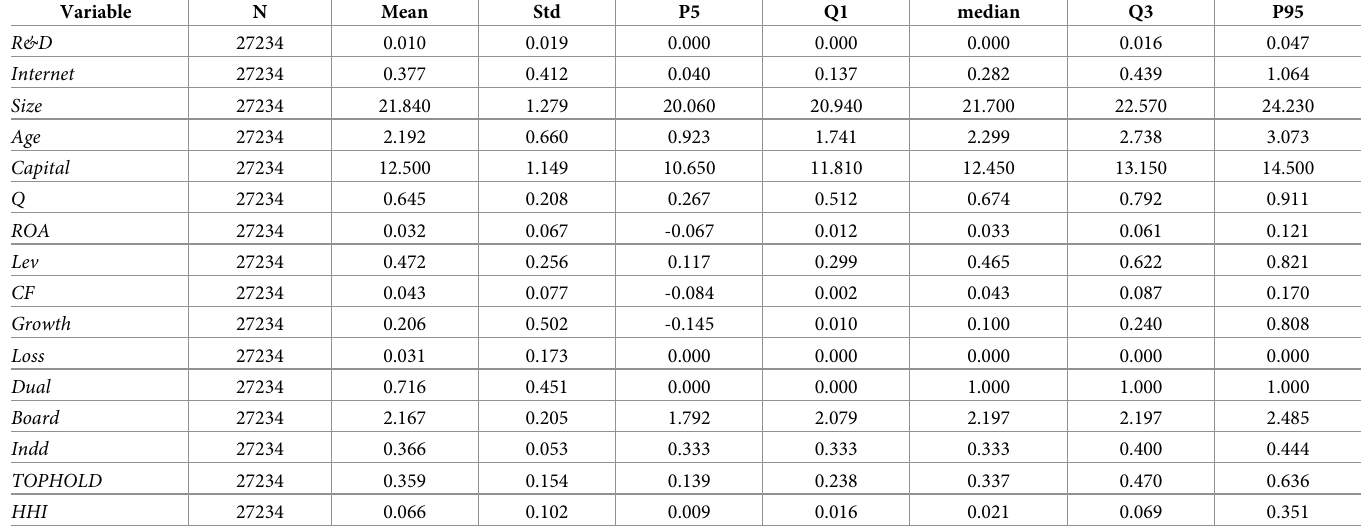
Table 1. Summary